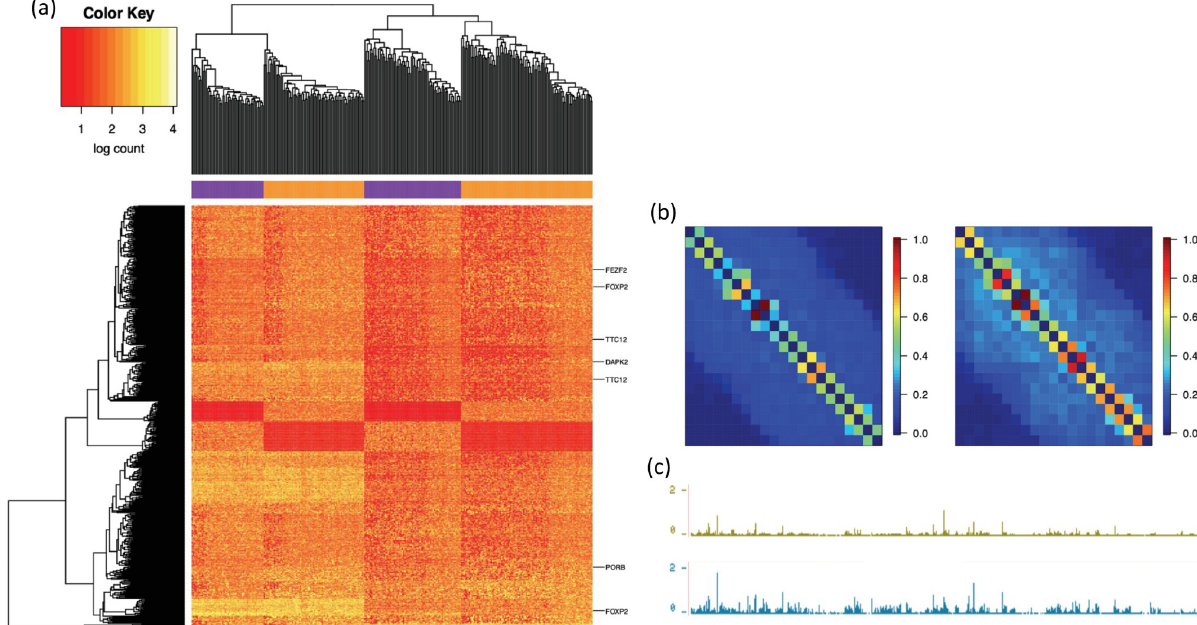
Fig 4. Correspondence between differential 3D structures and differential gene expressions among further subtypes. (a) Heatmap of 500 positions in the 2D interaction matrix with the largest variation among the cells (each row is a position and each column is a cell), with a 2-way clustering outcome placing the L4 cells into the two purple groups and the L5 cells into the two orange groups, and genes showing differential expression [28] indicated on the right edge of the heatmap; (b) Mega 2D matrices of normalized and scaled interaction intensities displayed as heatmaps, with the left for L5T1 and right for L5T2; (c) Mean gene expression for two L5 subtypes described in the literature